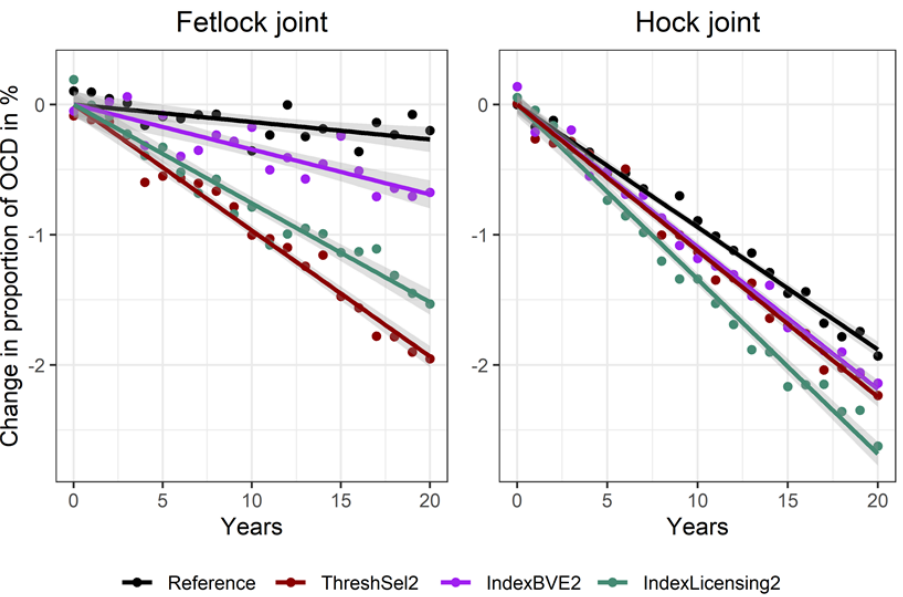
Figure 5. Proportion of unselected offspring with OCD in fetlock joints and hock joints for a reference scenario and for three different strategies for selection against OCD.